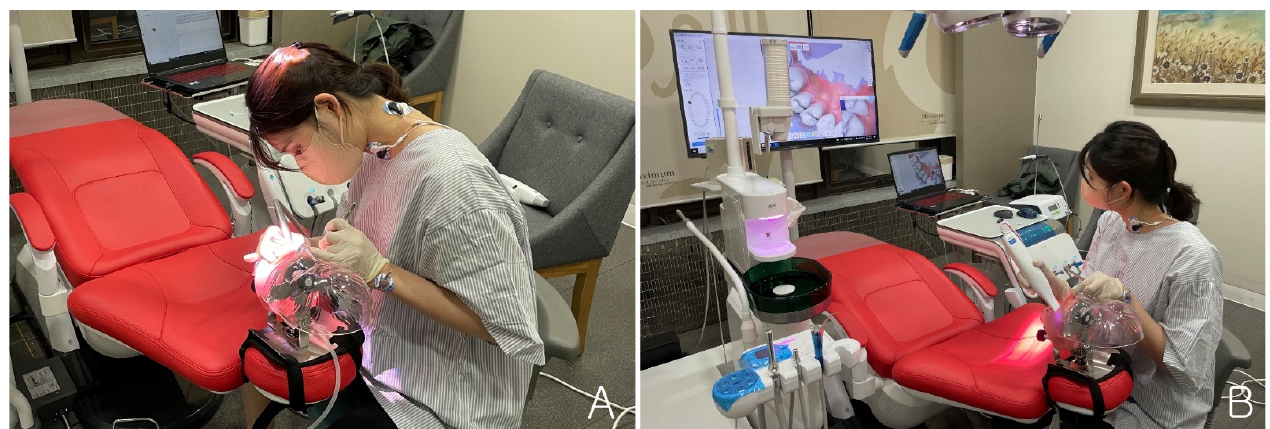
Figure 2. Electromyography measurements during dental simulations. ( A ) Tooth preparation simulation; ( B ) Intraoral scanning simulation.